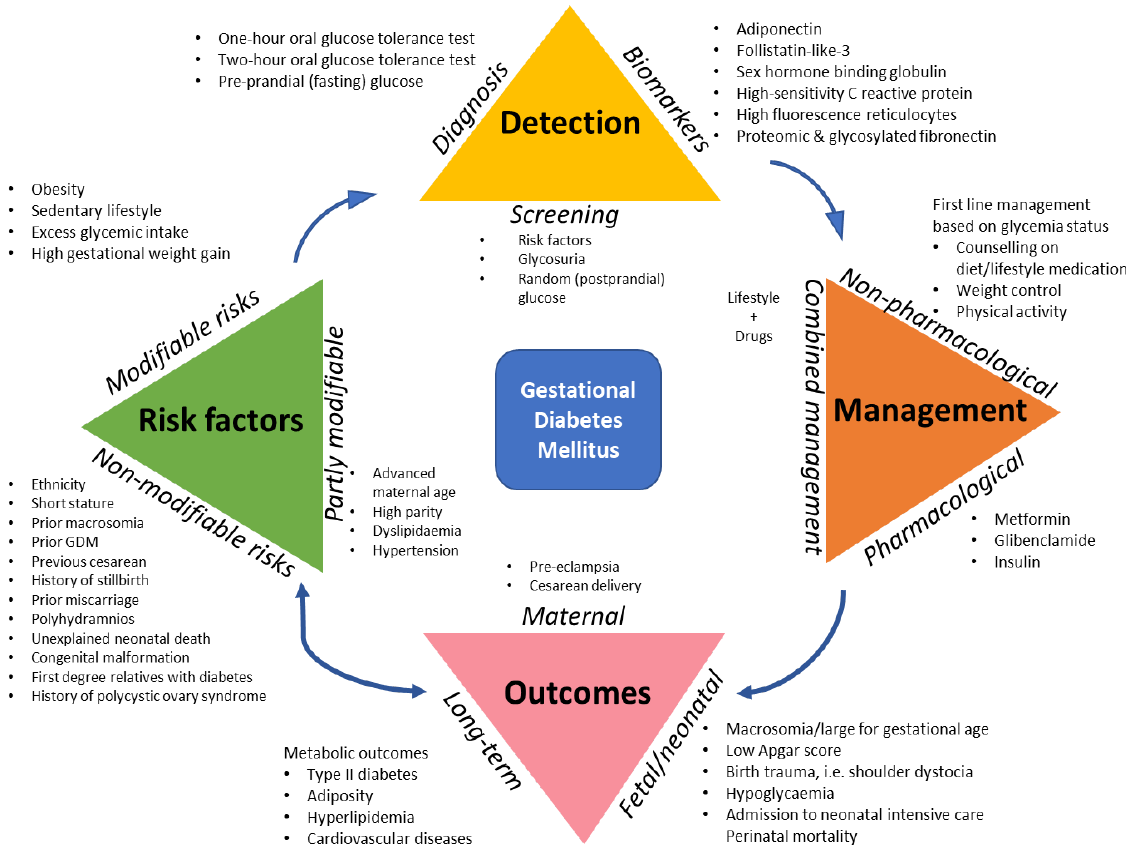
Figure 1. Conceptual framework showing the current areas of gestational diabetes research. Note: Author designed. In Ghana, GDM prevalence per 2-h OGTT ≥8.5 mmol/L (153 mg/dL) is 9.3% [21].